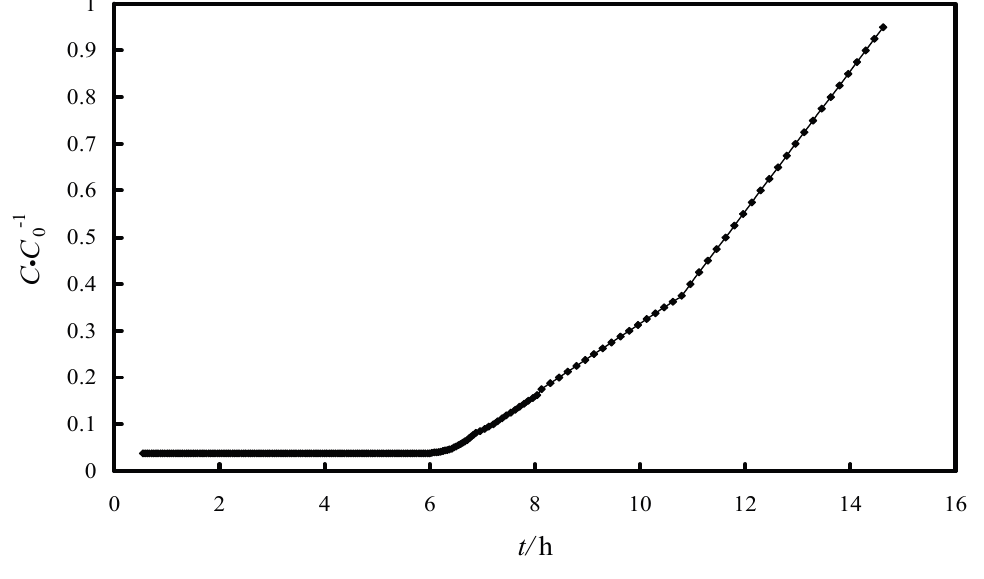
Figure 13. Linearized form of logit